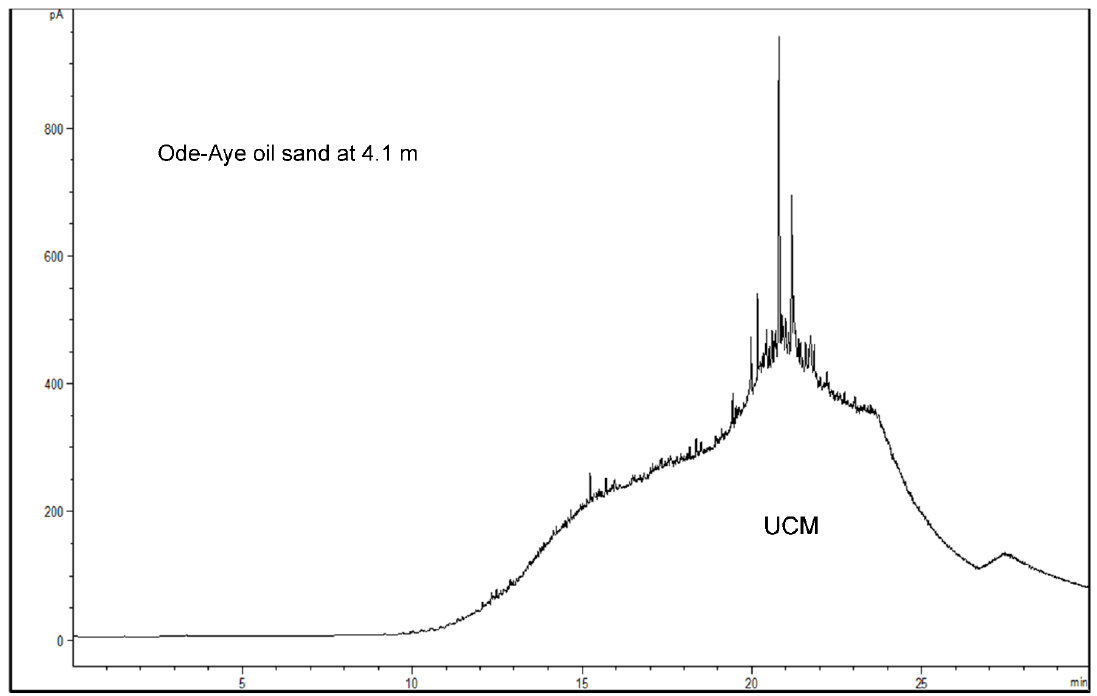
Figure 4. TD-GC result showing the chromatogram of Ode-Aye-1 oil sand at a depth of 4.1 m. The response intensity (pA) is displayed on the y -axis, while the retention time is shown on the x -axis in minutes. The chromatogram illustrated an unresolved complex mixture (UCM) below the peaks, indicating biodegraded oil.